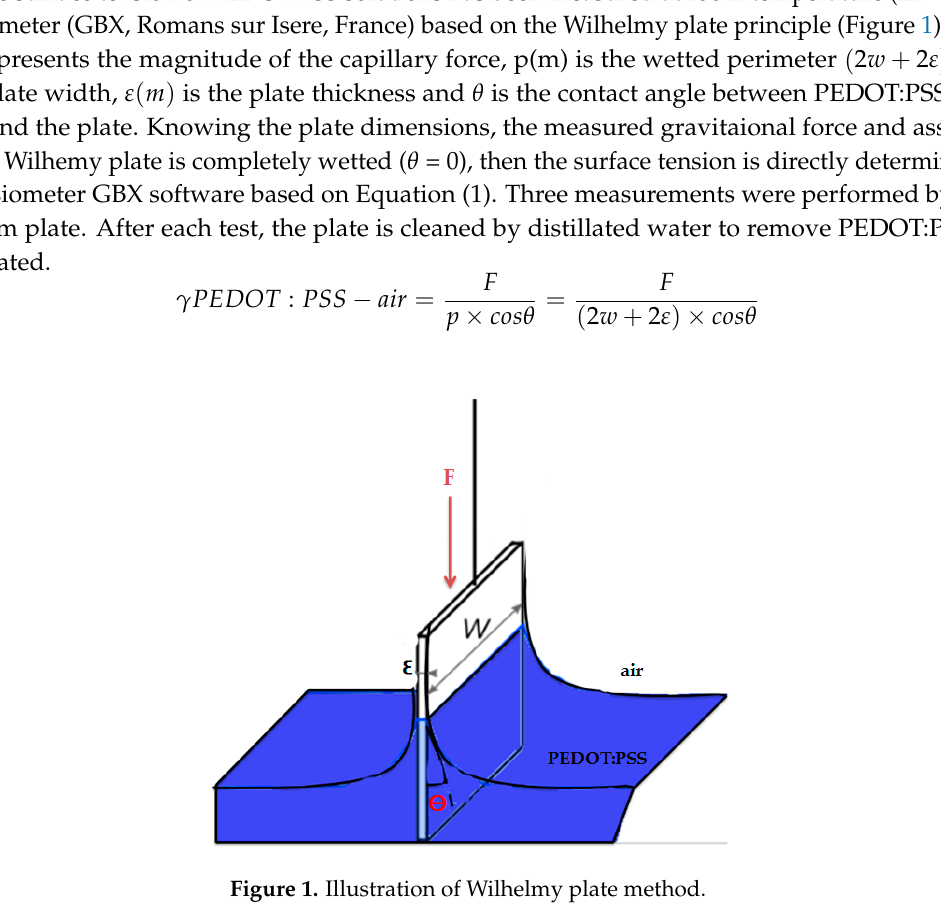
Figure 1. Illustration of Wilhelmy plate method.